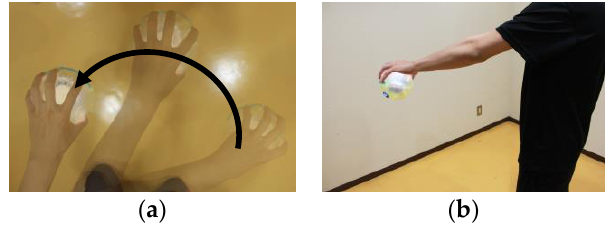
Figure 7. Experimental setup for circular hand motion: ( a ) Top view; ( b ) Side view.